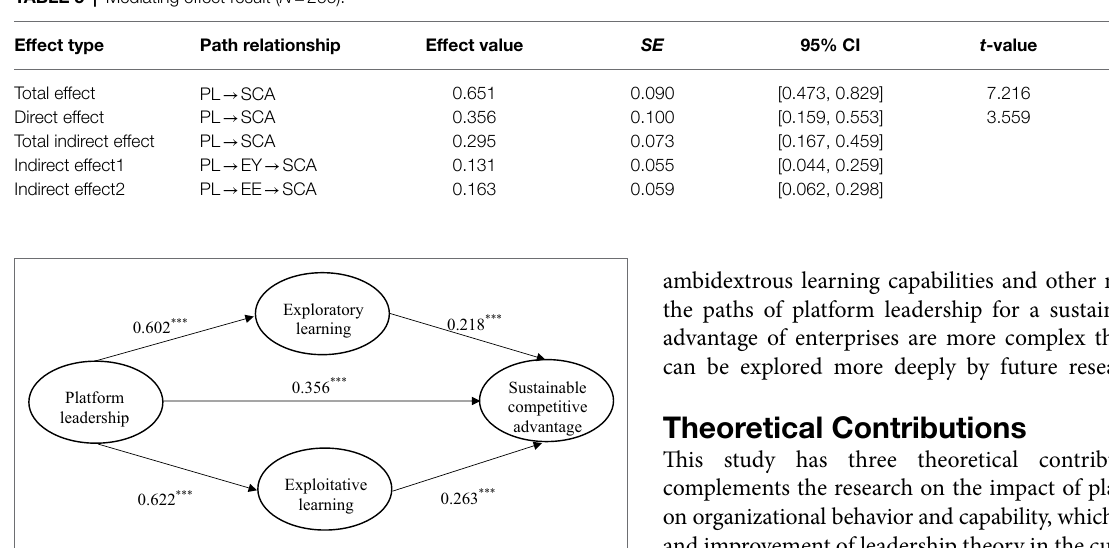
TABLE 5 | Mediating effect result ( N = 266).